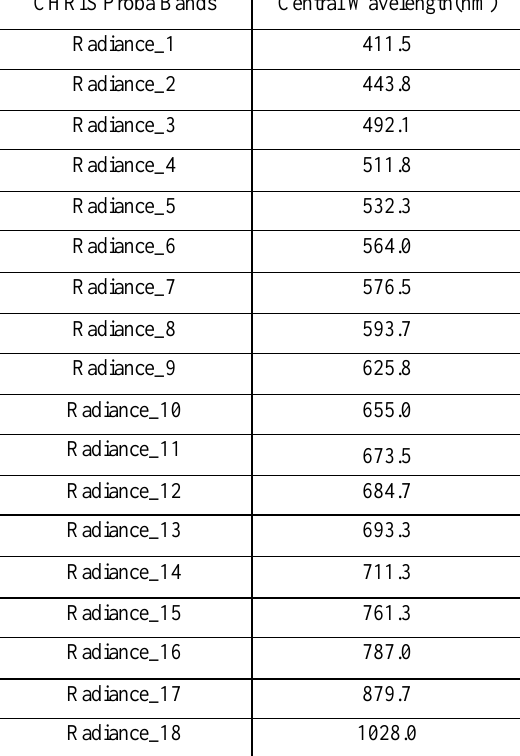
Table 1. Spectral Wavelenghts of Proba Sensor